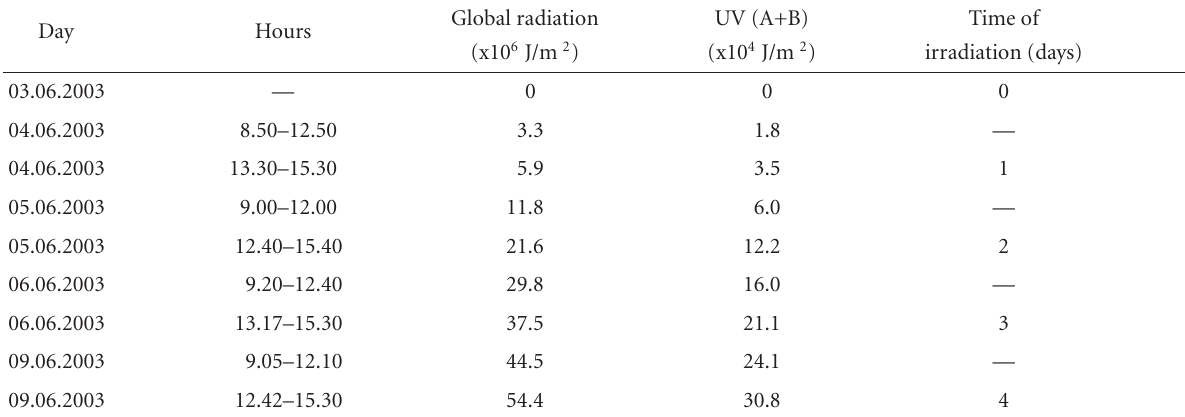
Table 1: Doses of solar radiation during the specimens exposition.